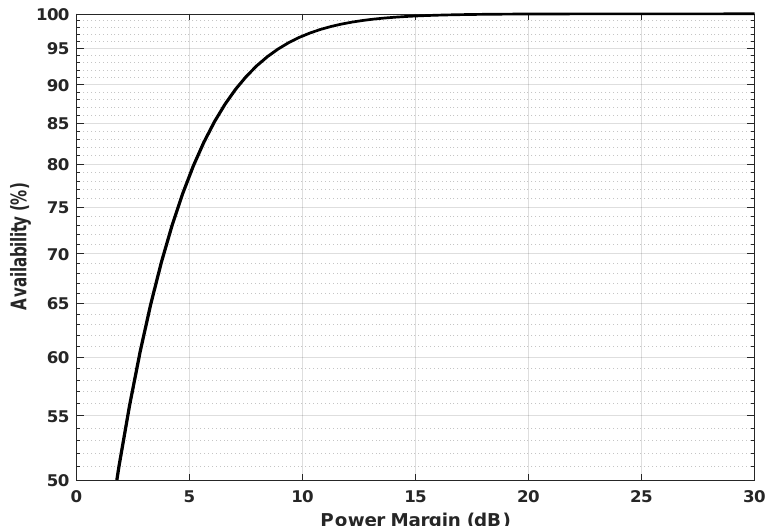
Figure 13. Proposed System Summer